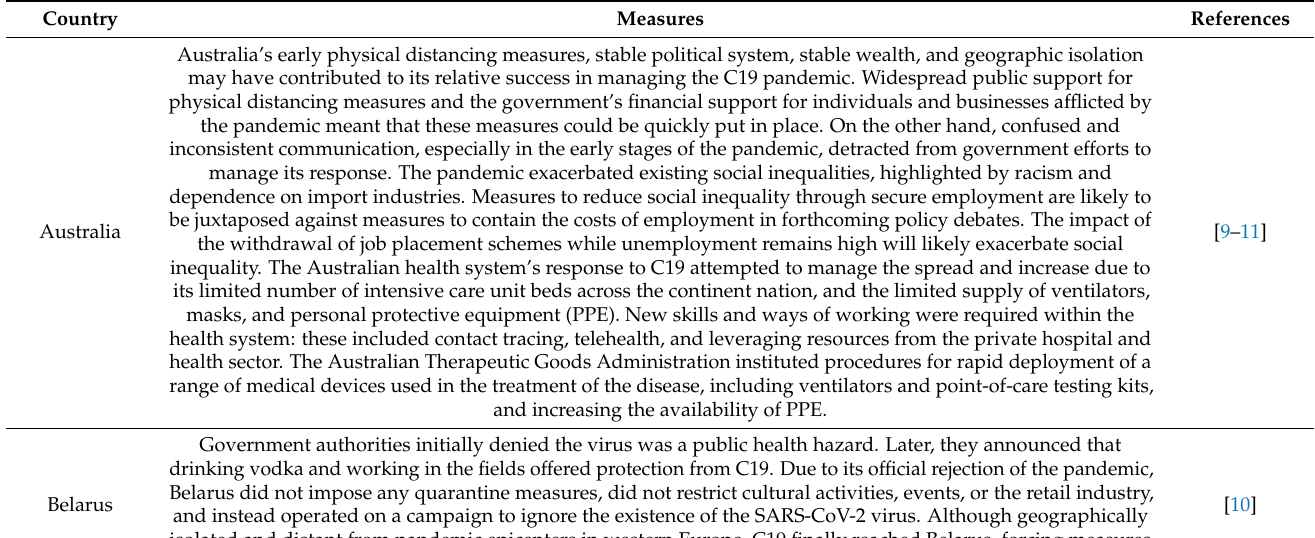
Table 1. A select list of nations that highlight approaches that nations took to manage